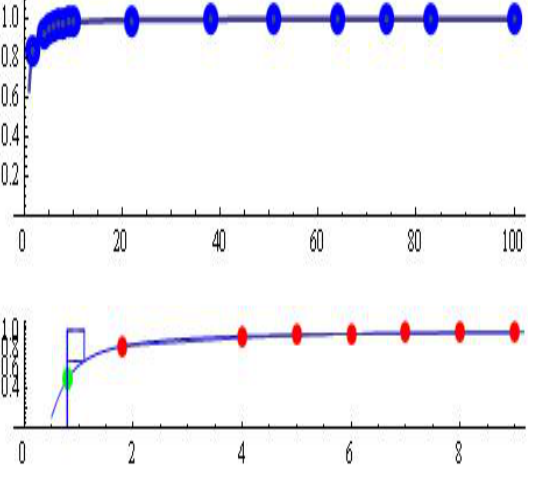
Fig. 11. The fitted model Q 1 ( t ) .